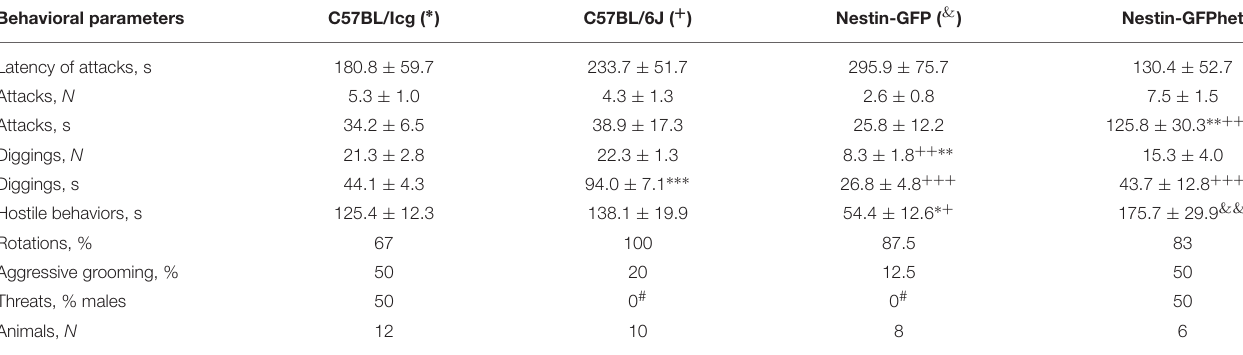
TABLE 1 | Behavior of C57BL/Icg, C57BL/6J, Nestin-GFP, and Nestin-GFPhet winners in agonistic interactions.